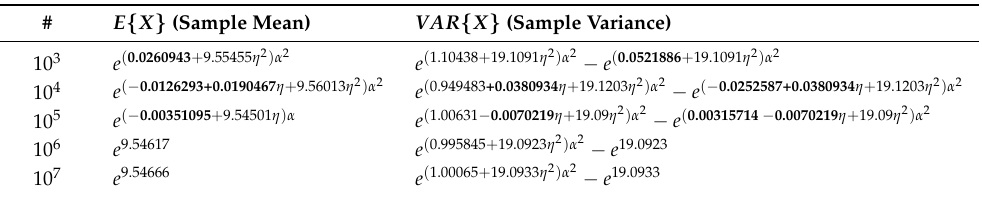
the threshold 2.5 · 10 − 3 to be equal to zero. Now the disagreement between theory and practice is still in place for small sample sizes (up to 10 5 ), but it disappears when the sample size is (cid:62) 10 6 . In